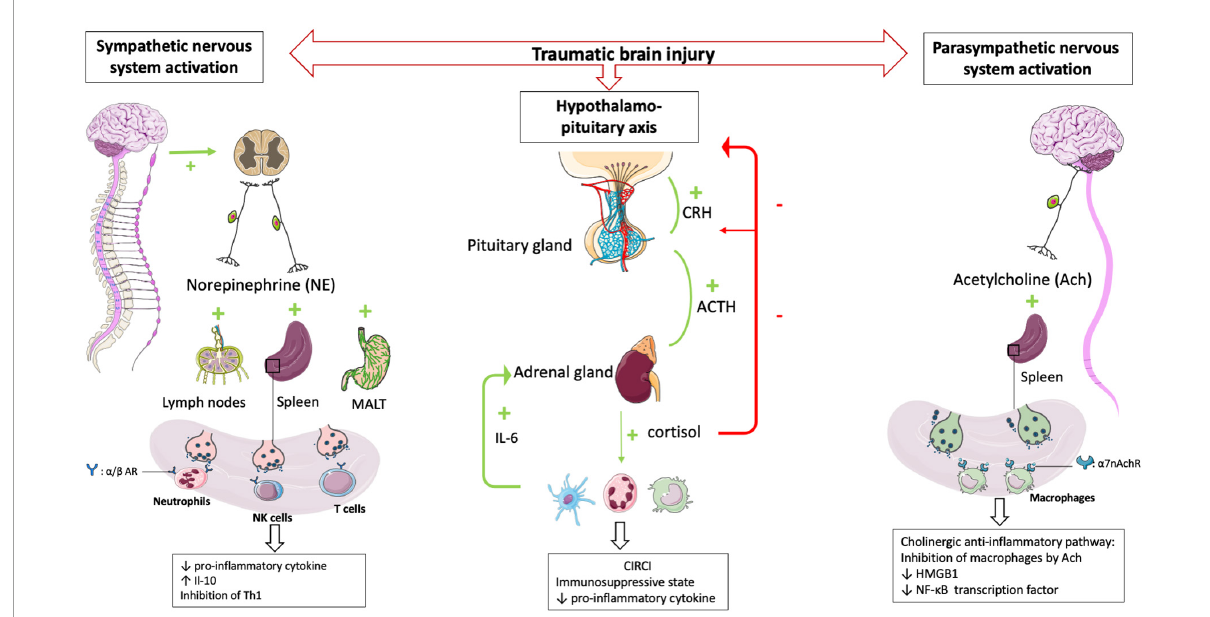
FIGURE2 HPA axis and autonomic nervous system (i.e., sympathetic nervous system and parasympathetic nervous system) plays central role in regulating peripheral immune cells after TBI. After a TBI, the sympathetic and parasympathetic nervous systems stimulate the secondary lymphoid organs via their neurotransmitters (norepinephrine and acetycholine respectively) leading to a state of immunodepression due to the loss of inflammatory functions of the leukocytes. Post-traumatic activation of HPA axis leads to CIRCI and deepens the immunosuppressive state. α / β AR , α / β adrenergic receptor; α 7nAchR , α 7 subunit of the acetyl choline